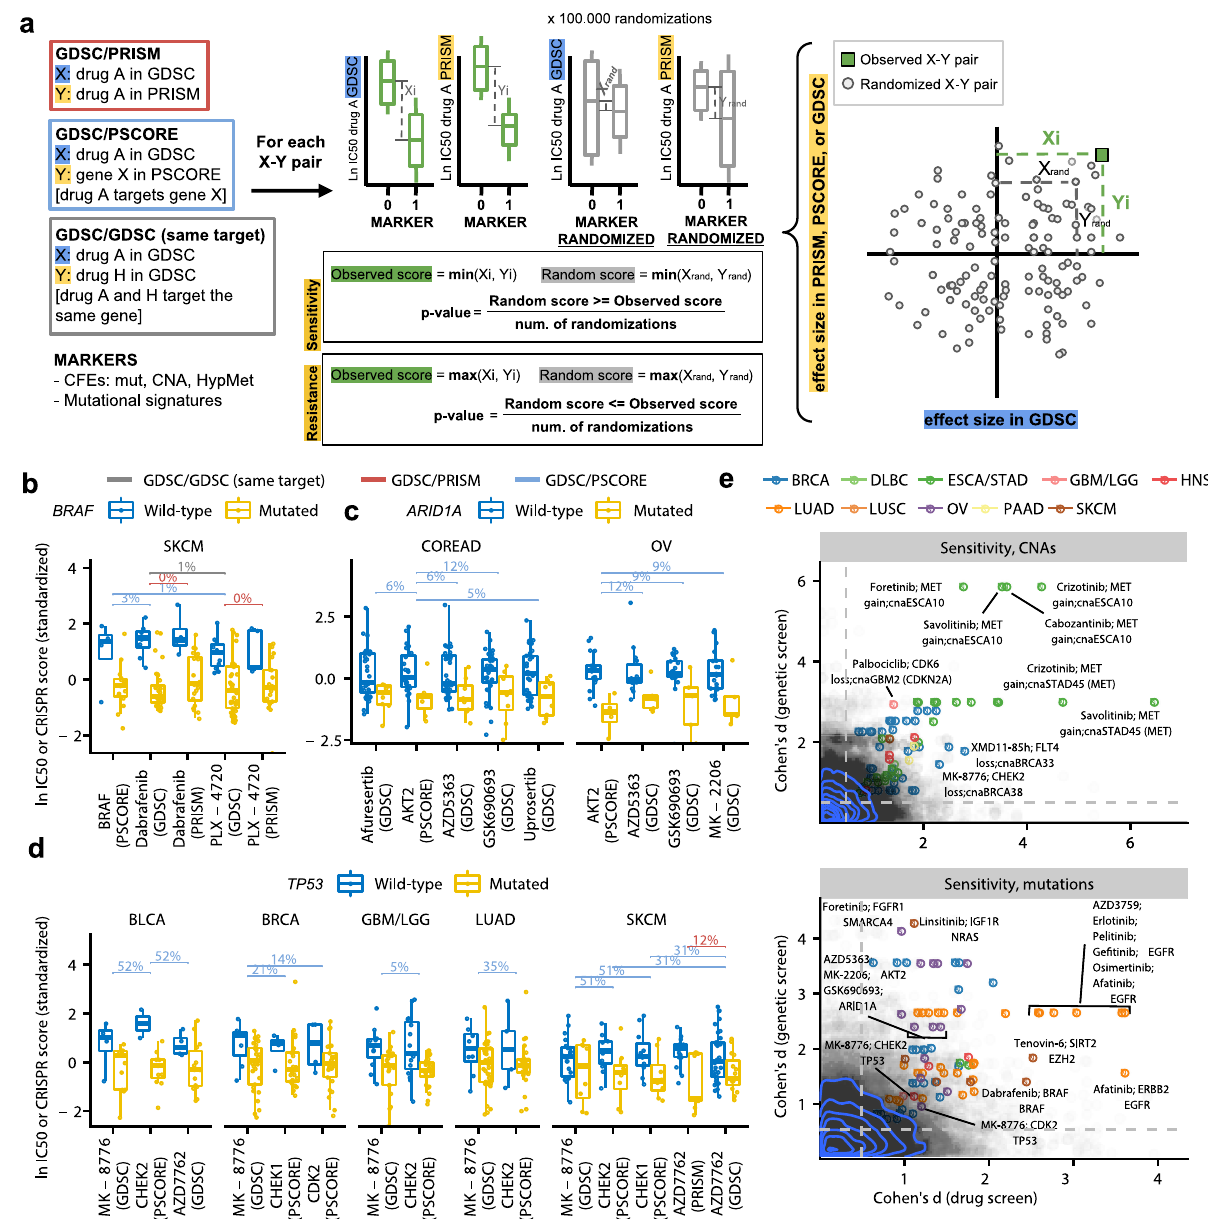
Fig. 3 Detecting robust associations between genetic or epigenetic markers and drug sensitivity by replication across measurements. a A schematic of the randomization test methodology to detect replicating associations using three different tests: (i) consistent effects of a drug between two screening assays (GDSC/PRISM), (ii) effects of a drug consistent with effects of knockout of the target gene (GDSC/PSCORE), and (iii) effects consistent across different drugs that share the same molecular target (GDSC/GDSC or “ same target ” ). Box plots and scatterplot are illustrative. b – d Examples of replicated associations of a known example of oncogene addiction (to BRAF , b) and of additional cancer vulnerabilities associated with mutations in tumor suppressor genes ( ARID1A , c ; TP53 d ). Y-axes show a Z-score derived from either the ln IC50 value (i.e. drug sensitivity, in columns labeled “ GDSC ” or “ PRISM ” ) or from the CRISPR essentiality score (in the column labeled “ PSCORE ” ). Horizontal brackets show FDR for replicated signi fi cant difference between wild-type and mutant genotypes, obtained via a randomization test in panel a , where color denotes the type of the replication test ( “ GDSC ” , “ PRISM ” or “ PSCORE ” ). The center line of box plots denotes medians and the hinges correspond to the 1st and 3rd quartiles, while whiskers extend to 1.5× IQR from the hinges. e, Effect sizes of markers that associate with drug response in the GDSC drug screen (X-axes) and with response drug target gene knock-out in the Project SCORE genetic screen (Y-axes), shown separately for copy number alterations (CNA) and mutations in cancer genes (Muts). Gray points represent all tested associations, while colored points denote the statistically signi fi cant associations that also meet an effect size threshold. Blue lines are the contours of the 2D kernel density estimates. Representative points are labeled. Drug names on grouped labels ( “ Muts ” sub-panel) are ordered by their appearance on the plot from left to right. Source data are provided as a Source Data fi le.